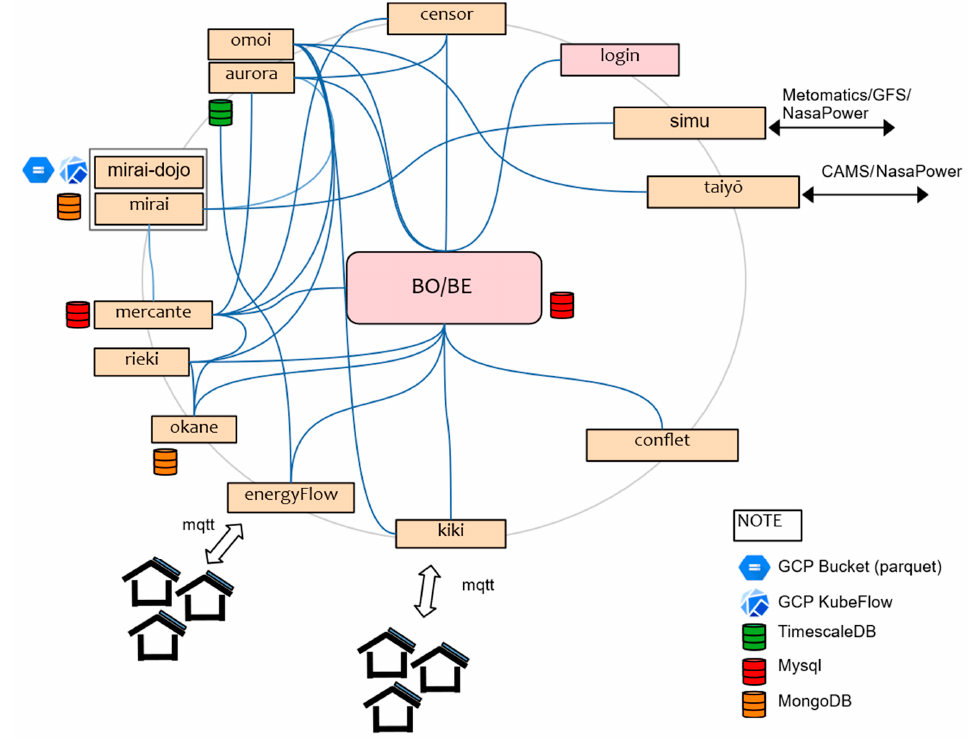
Figure 4. The cloud infrastructure’s microservices.